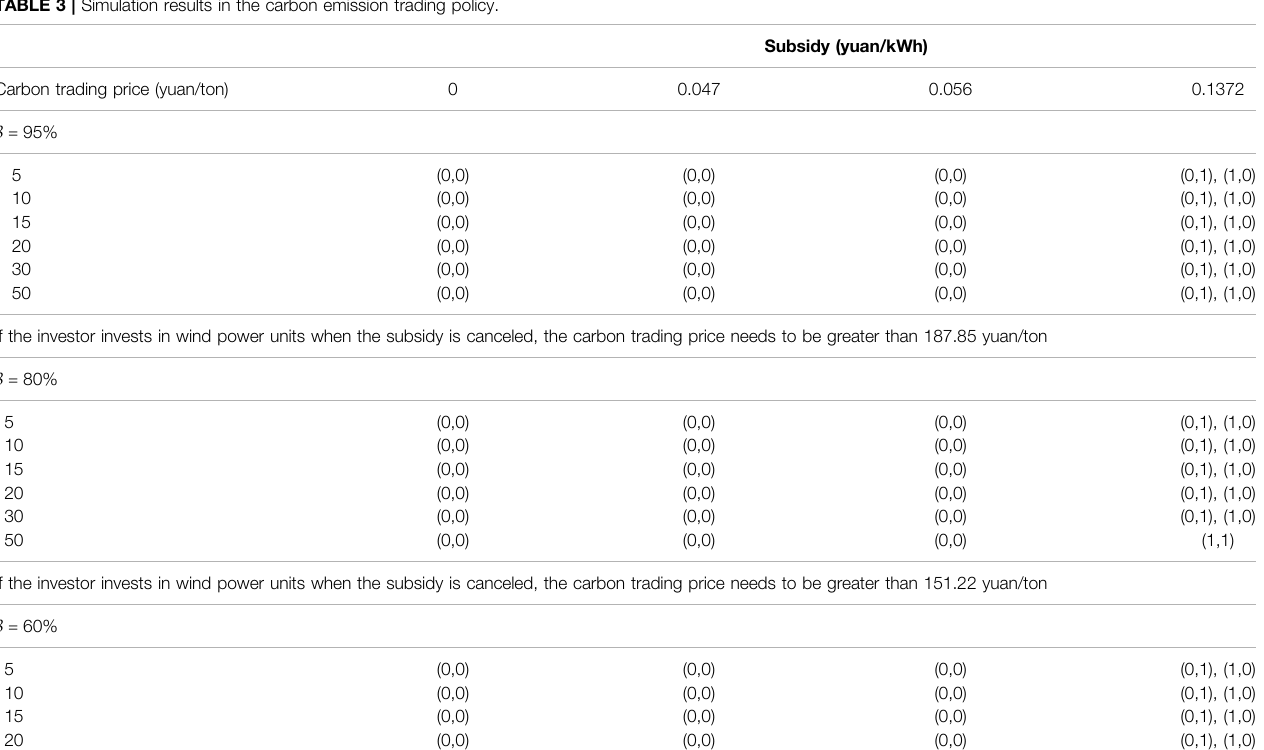
TABLE 3 | Simulation results in the carbon emission trading policy.